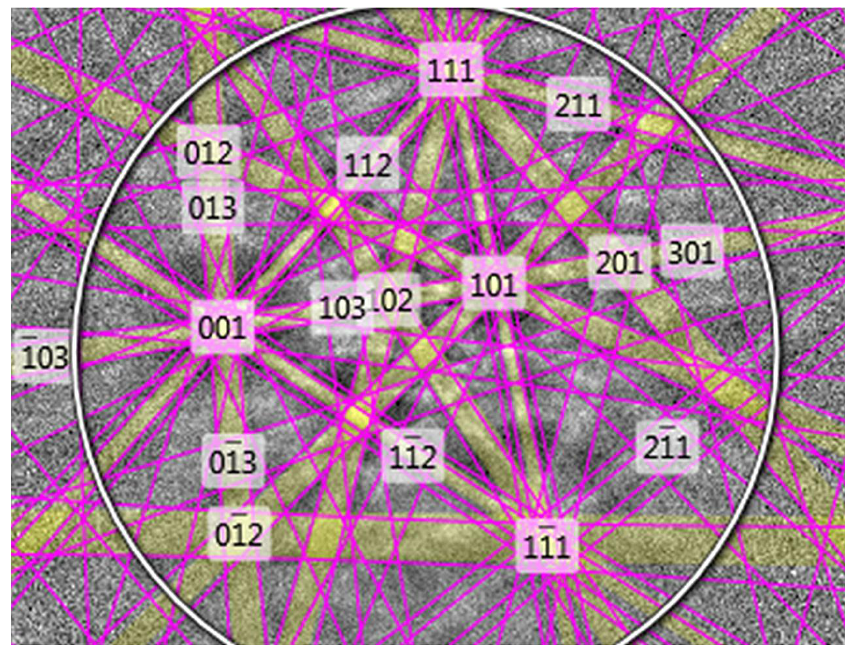
Figure 3. Indexed EBSD Pattern of sputtered area (from Figure 2a) of steel 1.4509 (AISI 441).